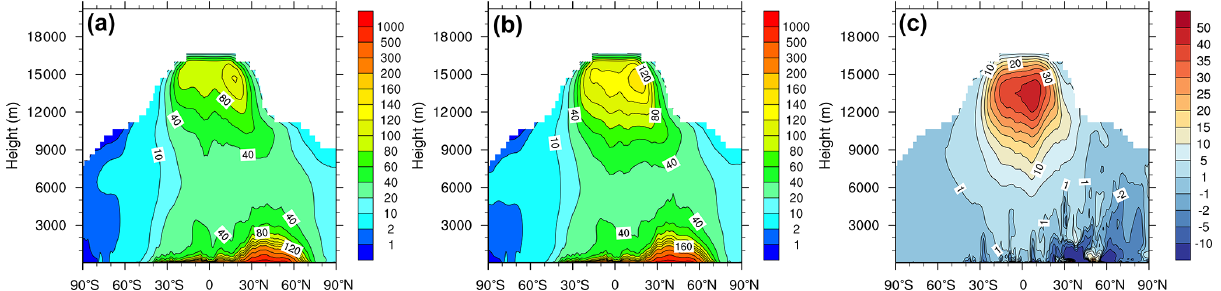
Figure 10. Zonal annual-mean total tropospheric NO x (as NO 2 , pptv) modelled using (a) the default PR92 parameterisations (Run 1) and (b) the new lightning flash-rate parameterisations from this study (Run 2). The difference between Run 2 and Run 1 is shown in panel (c) .